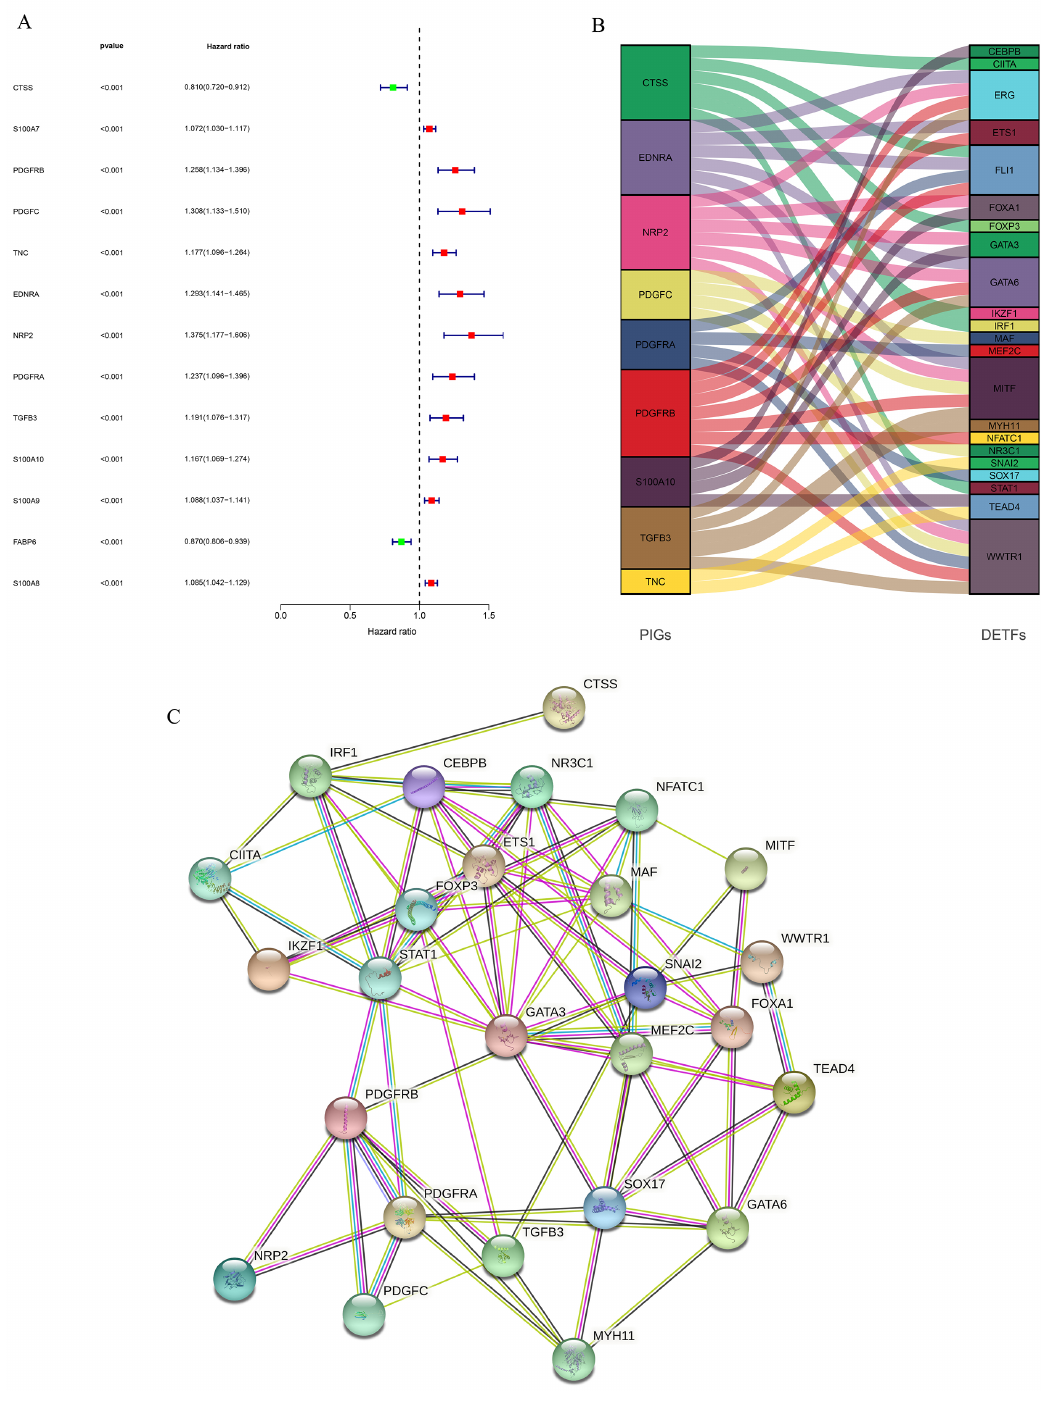
Figure 4. Identification of PIGs and analyses of regulatory networks and interactions between PIGs and DETFs. ( A ) Forest plot based on univariable Cox proportional hazard regression analysis showed the PIGs and their hazard ratios. ( B ) Alluvial diagram of the PIGs and DETFs revealed their regulatory network. ( C ) PPI network between PIGs and